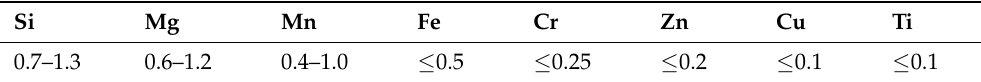
Table 1. Mass fractions of the alloying elements of EN AW-6082 T6 (Al balance). Si